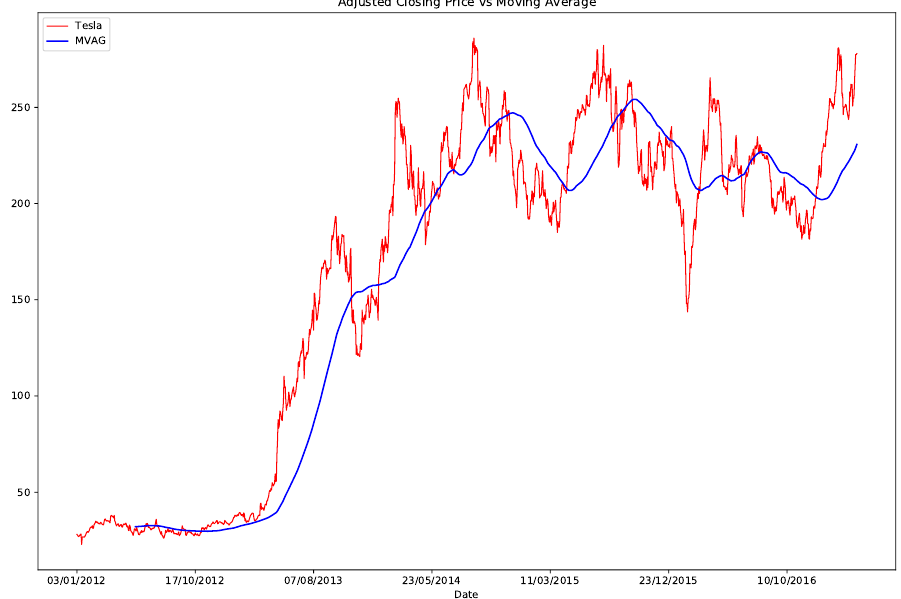
Figure 5. This figure represents the daily closing prices of the Tesla